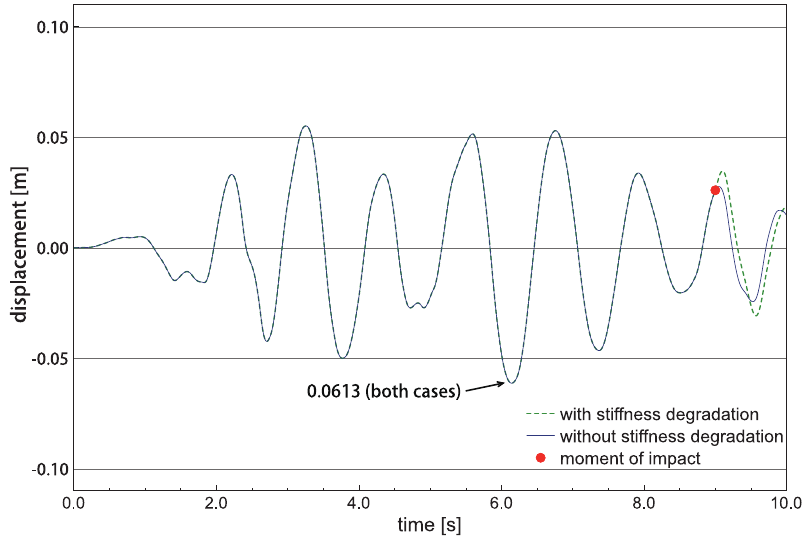
Fig. 13. Displacement time history of the first story of building under the El Centro earthquake with and without considering the degradation of horizontal stiffness for impact at t = 9 s. is just approaching its extreme position). In the case of impact at t = 6 s (see Fig. 10), for example, the increase in the peak displacement due to the degradation of horizontal stiffness is as high as 30.5%. Relatively high increase in the peak displacement value (by 11.1%) can also be observed in Fig. 7 obtained for impact at t = 3 s. On the other hand, when impact takes place when the displacement of the building is relatively small (see Figs 5, 6, 8 and 11), the incorporation of the stiffness degradation on the structural response is less important, even that some increase in the peak displacement (on the order of 1–2%) due to the degradation of horizontal stiffness has also been recordered (see Table